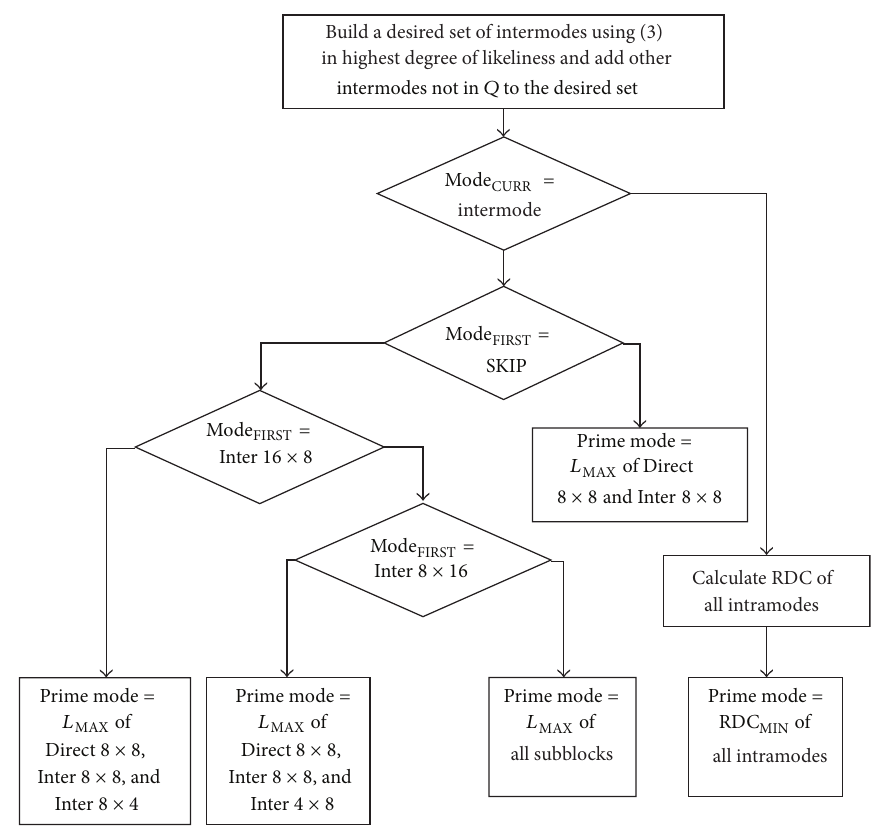
Figure 2: Flowchart of likelihood mode decision